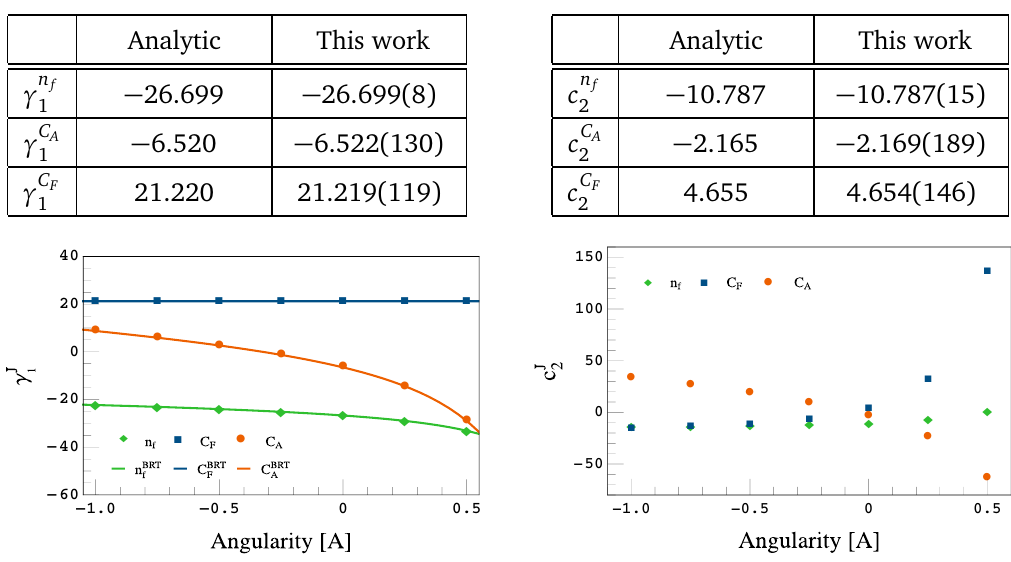
Table 1: Two-loop non-cusp anomalous dimension (left) and finite term of the renor- malised jet function (right) for thrust. The analytic results have been extracted from [ 16 ] .